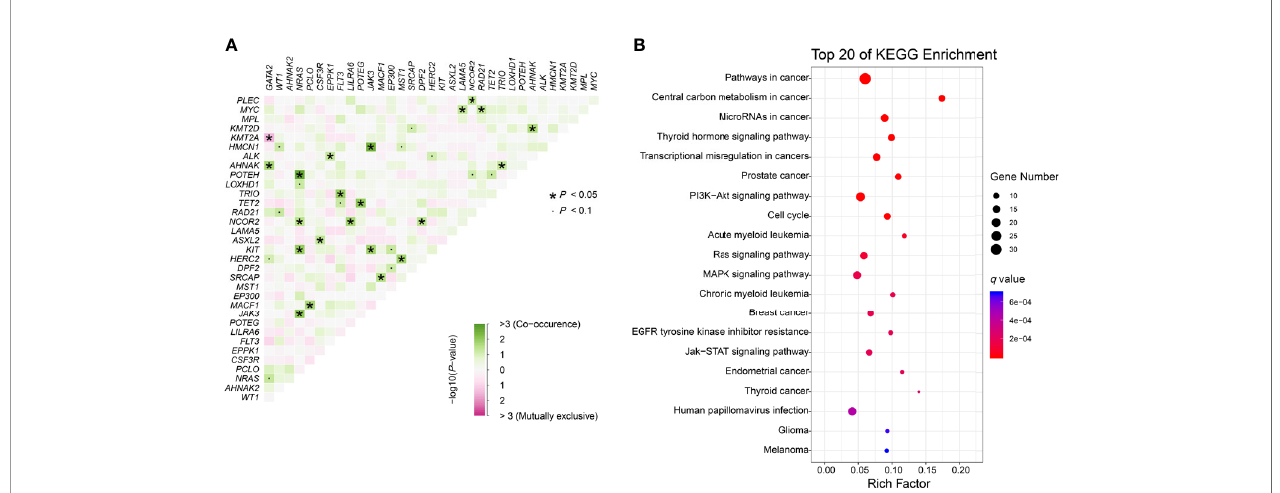
FIGURE 3 | Genomic analyses. (A) Pairwise association between genes mutated in ≥ 10 patients. Green colors indicate positive association and pink colors indicate negative association. (B) KEGG enrichment analysis. The top 20 pathways are shown. Dot size depends on the mutation number and color depends on the q value (adjust P value).